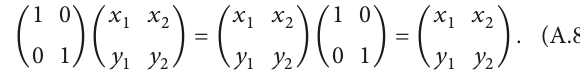
Figure 12: Points 𝑎 and 𝑏 can be transformed into points 𝑝 and 𝑞 by a linear